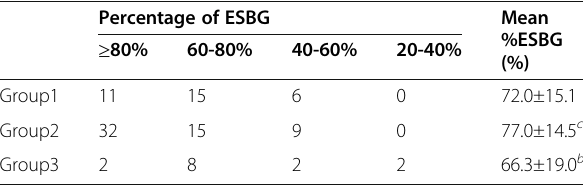
Table 4 The ESBG percentage distribution in different IPL groups and mean